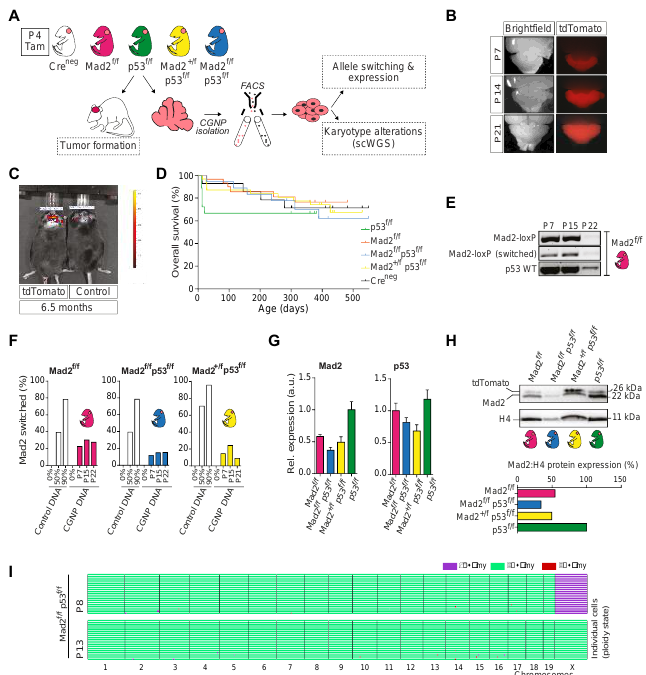
Figure 4. Induction of CIN/aneuploidy is not tolerated in the developing cerebellum and does not provoke medulloblastoma. ( A ) Schematic overview of the transgenic mouse model and experimental setup. Five experimental groups of P4 pups containing the tdTomato reporter were generated: Cre Negative (white), Mad2 f/f (pink), p53 f/f (green); Mad2 +/f , p53 f/f (yellow), and Mad2 f/f ; p53 f/f (blue). P4 pups were treated once with Tamoxifen by oral gavaging. Mice were monitored for tumor formation. Addi- tionally, fluorescent CGNPs were isolated at different time points for further analyses. ( B ) Stereoscopic fluorescent images showing tdTomato expression in cerebellum between postnatal day P7 and P21. ( C ) IVIS images demonstrating tdTomato expression in the cerebellum of a 6.5-month-old transgenic and control mouse. ( D ) Kaplan–Meier survival curve showing overall survival of the five experimental groups described at ( A ). ( E ) Conventional genomic PCR assessing the switching efficiency of the floxed Mad2l1 alleles in Mad2 f/f cerebella of postnatal day P7 (n = 1), P15 (n = 1), and P22 (n = 1) mice. Upper bands: floxed (unswitched) allele; middle bands: switched Mad2l1 allele; lower bands: wild type Trp53. ( F ) Bar charts showing the switching efficiency of the Mad2l1 floxed allele in Mad2 f/f (n = 1), Mad2 f/f ; p53 f/f (n = 1), and Mad2 +/f ; p53 f/f (n = 1) sorted CGNPs or titrated control at P7, P15, and P21 at the genomic level, as assessed by quantitative genomic PCR. ( G ) Bar charts showing the switching efficiency of the Mad2l1 and Trp53 floxed alleles at the mRNA level in P7 CGNPs, as assessed by quantitative RT-PCR. ( H ) Western blot showing the switching efficiency of the Mad2l1 floxed allele at the protein level in P7 CGNPs. ( I ) scWGS data of sorted P8 and P13 Mad2 f/f ; p53 f/f CGNPs. Each colored line represents the karyotype of a single cell (P8, n = 19; P13, n = 19 cells). Chromosomes are indicated on the X -axis. Colors indicate the ploidy state of their corresponding region, as stated in the